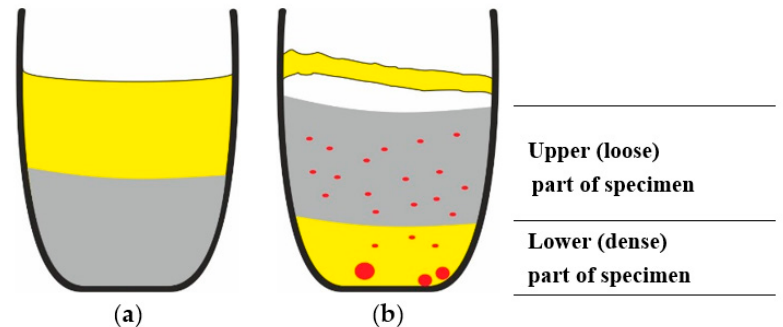
Figure 9. Schematic images of cross sections of the crucibles: ( a ) filled with CdO-C mixture (grey colour) and CKN-salt slag (yellow) before the thermal treatment; ( b ) CdO-C mixture, Cd (red colour) and CKN-salt slag after thermal treatment.